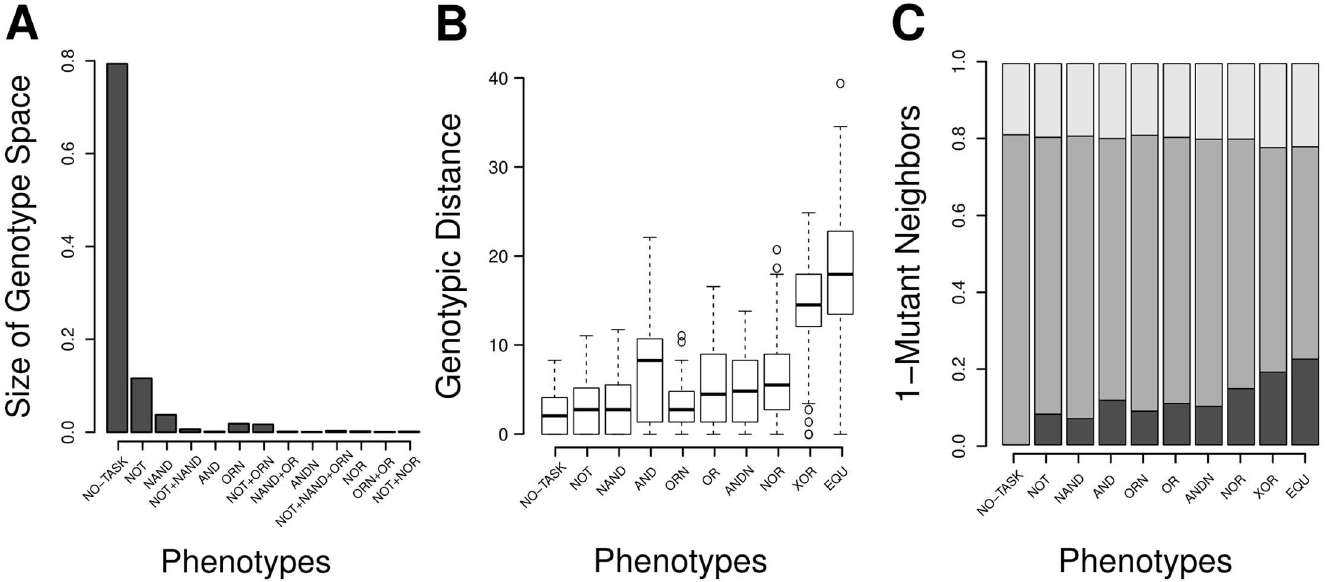
Fig 2. Genotype space characterization. (A) A measureof the fraction of viable genotypespace (see Methods)in the neighborhood of 1000 merely viablegenotypes.We computedthe number of 1-mutant neighborhoods of merely viableorganisms,in which a particularphenotype (includingthe merely viable) appeared at least once, dividedby 1000, i.e., by the total numberof neighborhoods examined.We then normalized this quantity so that the sum equalsone. Few phenotypes (e.g., that of merely viableorganisms and of organisms able to perform the NOT operation)are moderately frequent, whereasmost others (e.g., the NOR phenotype) are rare. (B) Genotypicdistances between100 pairs of genotypes per phenotype, after randomwalks aimingto reach one genotypefrom the other through multiple phenotype-preserving point mutations. Distancewas measured as the number of positions at which both genotypesdiffer (Hammingdistance). (C) Classification of genotypes that lie in the 1-mutant neighborhood of every organism havinga particular phenotype (x-axis). Each bar shows the fraction of those genotypes that are non-viable (light gray), viable having the same phenotypeas the focal phenotype (dark gray), and viable but havinga distinct phenotype (black). Phenotypes are arrangedfrom left to right in order of increasing complexity. Panels B-C are focused on single-traitphenotypes (i.e., phenotypes whoseorganismshave only the functionaltrait posedby a singlelogic operation)as well as merely viable organisms (labeledas